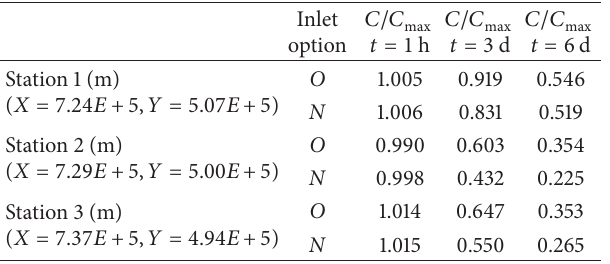
Table 2: Normalized contaminant concentrations obtained at three hypothetical sampling stations for the two inlet options O and N , at different